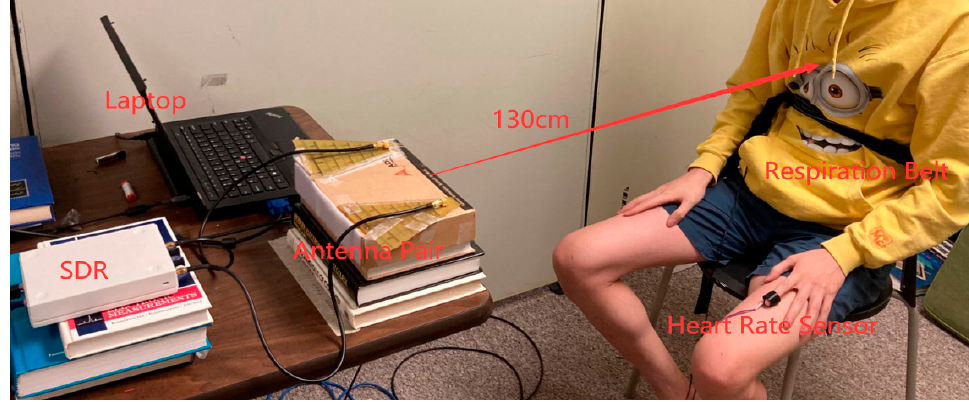
Figure 4. Example lab testing setup with a student volunteer sitting on a chair placed 130 cm away.